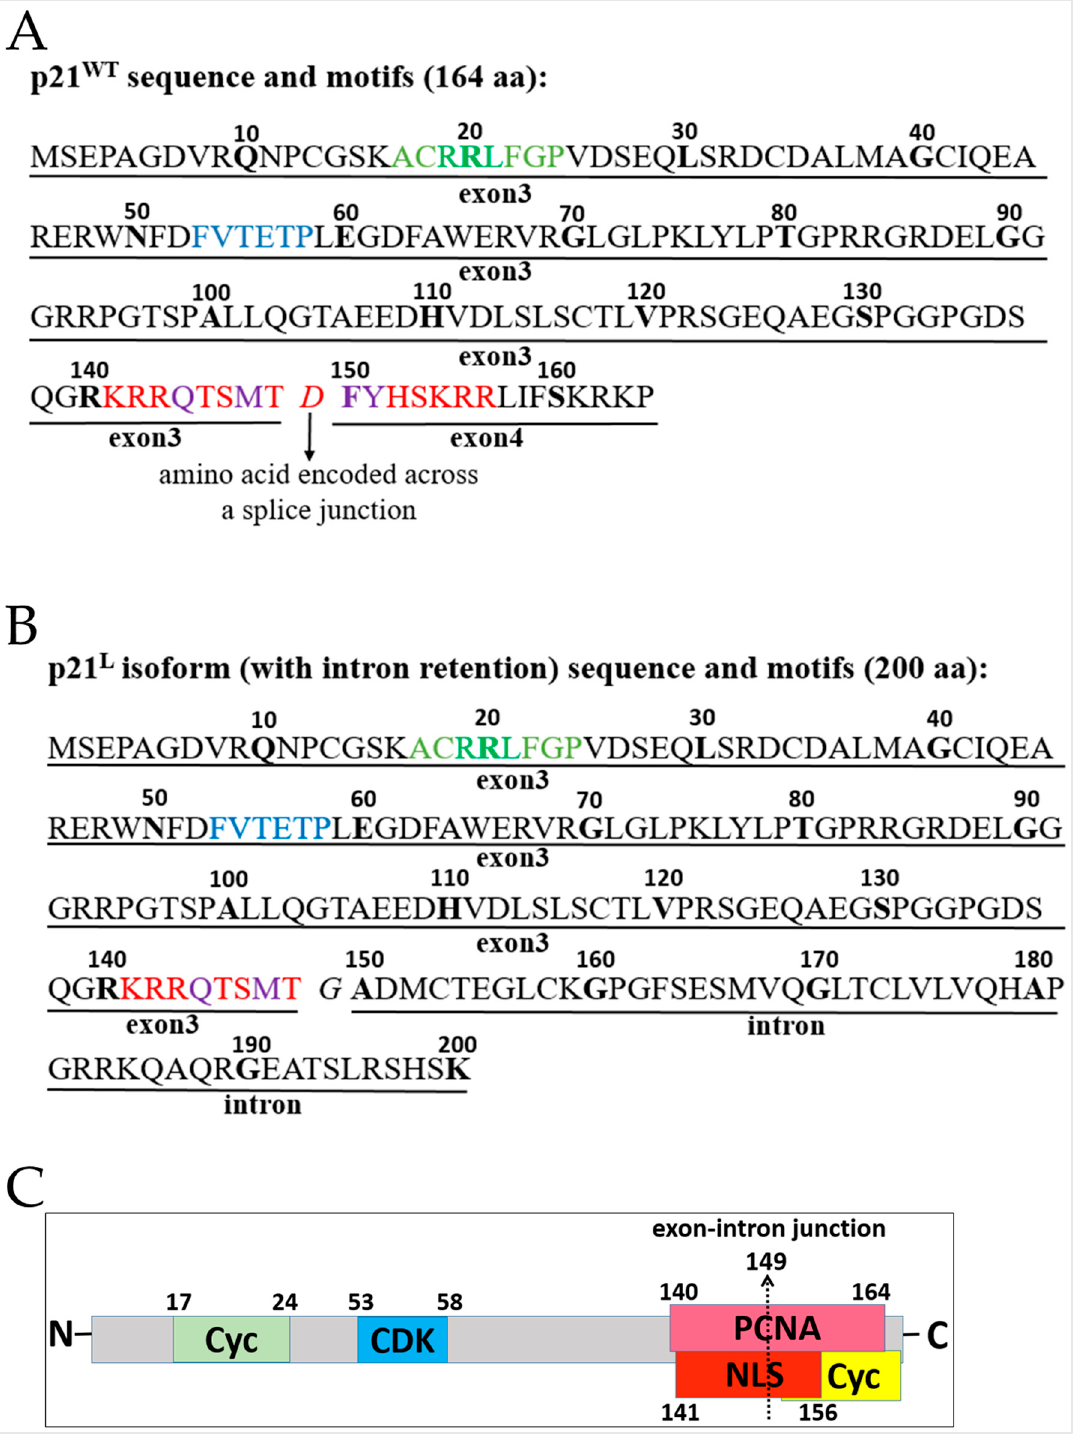
Figure 2. Comparison of the amino acid sequences and colour-highlighted motifs of the wild-type p21 and variant p21 L isoforms. ( A ) Wild-type p21; 17–24: RxL motif cyclin binding site; 53–58: CDK binding domain; 140–164: PIP-box K + 4 motif (Qxx[M/L/I]xx[F/Y][F/Y]) proliferating cell nuclear antigen (PCNA) interaction site; 141–156: nuclear localization signal (NLS). ( B ) The p21 L intron-retaining isoform of p21. The PCNA interaction site and nuclear localization domain are only partially present in the p21 L isoform with intron retention between exons 3 and 4. ( C ) Representation of p21 WAF1 protein with its protein-interacting domains; 149–200: novel C-terminal sequence.